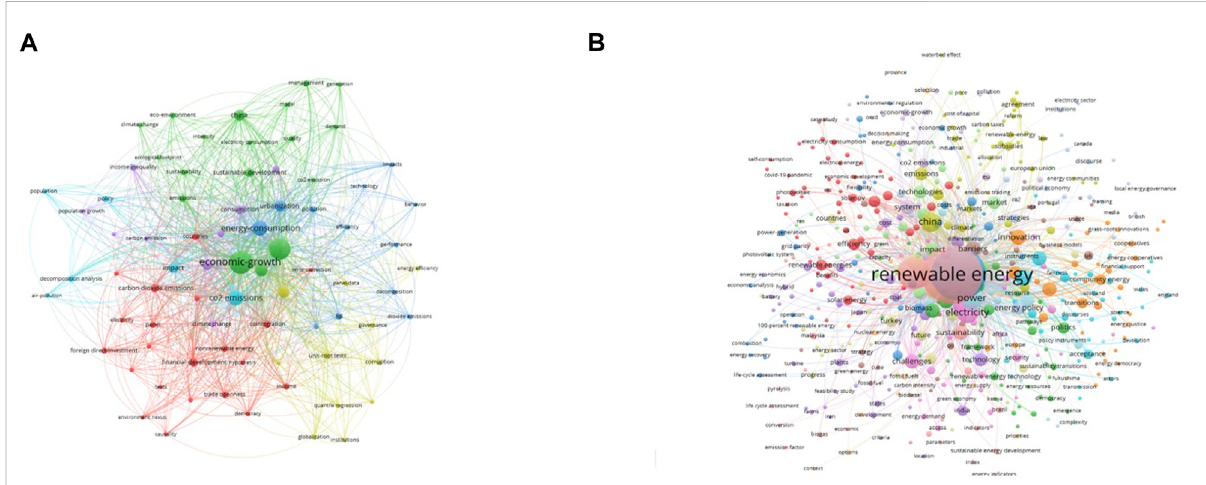
FIGURE 1 Bibliometric network correlation analysis for (A) environment — energy — economic growth nexus (B) renewable energy as search